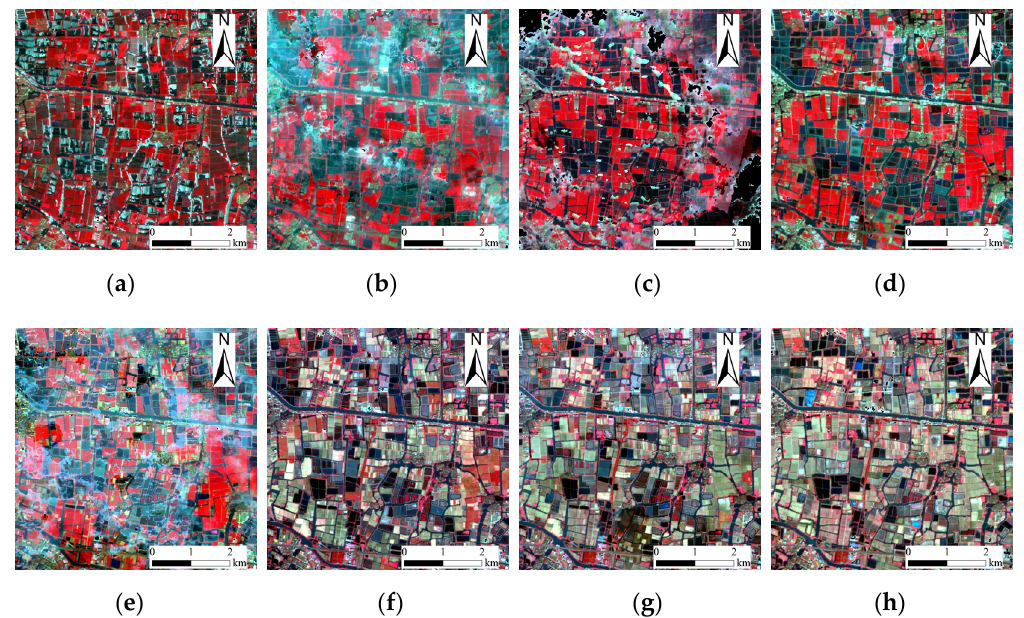
Figure 3. Sentinel-2 MSI images in the study area on July ( a ), August ( b ), September ( c ), the first half of October ( d ), the second half of October ( e ), the first half of November ( f ), the second half of November ( g ) and the first ten days of December ( h ), 2017.